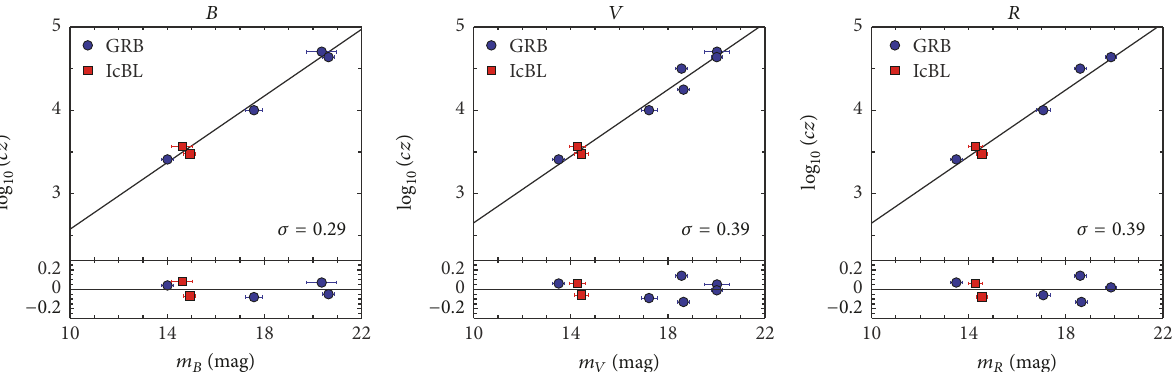
Figure 15: Hubble diagrams of relativistic SNe IcBL in filters 𝐵𝑉𝑅 , from [44]. GRB-SNe are shown in blue and SNe IcBL (SNe 2009bb and 2012ap) in red. Plotted in each subplot are the uncorrected magnitudes of each subtype and the fitted Hubble ridge line as determined using a bootstrap method. Also plotted are the rms values ( 𝜎 ) and residuals of the magnitudes about the ridge line. In the 𝐵 -band, the amount of scatter in the combined SNe IcBL sample is the same as that for SNe Ia up to 𝑧 = 0.2 [44, 278], which is 𝜎 ≈ 0.3